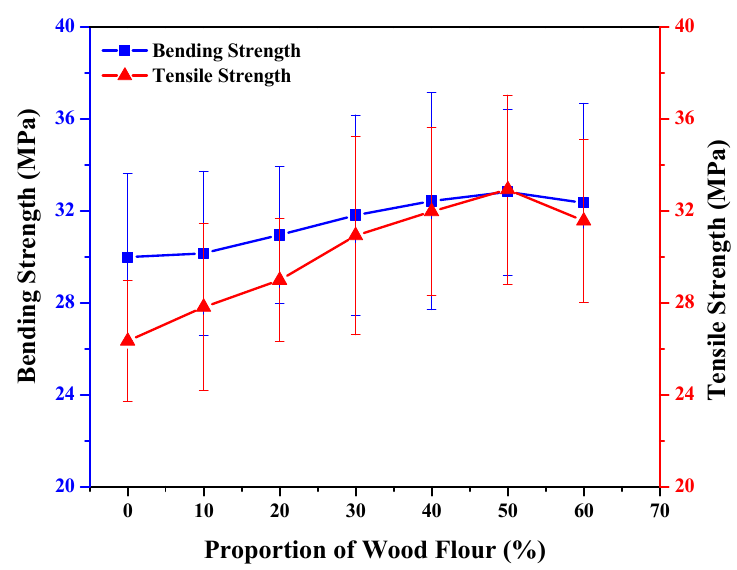
Figure 6. Bending and tensile strength at different wood flour proportions.